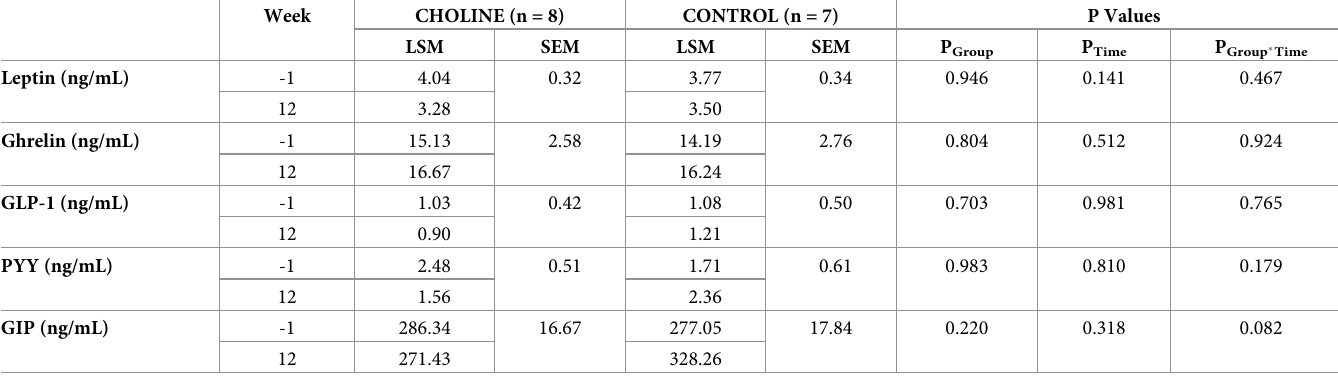
Table 5. Fasted serum satiety hormone concentrations of post-gonadectomy kittens supplemented with additional choline at 300 mg/kg BW 0.75 (CHOLINE, n = 8) compared to a group fed only the base diet (CONTROL, n = 7) over 12 weeks.